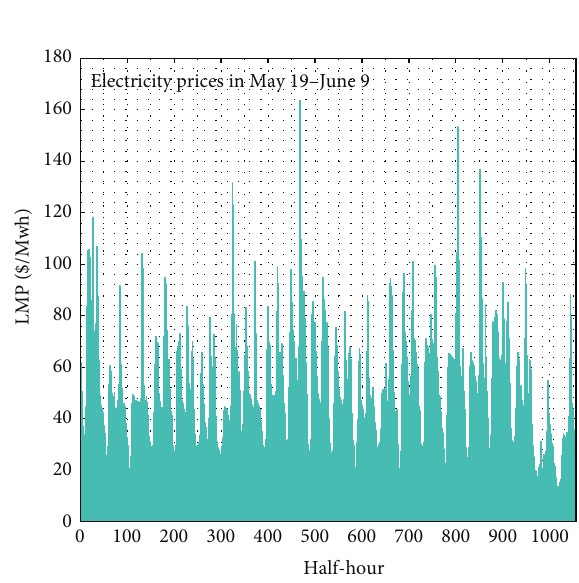
Figure 3: Electricity prices in the period from May 19 to June 9. Figure 4: Electricity demand in the period from May 19 to June